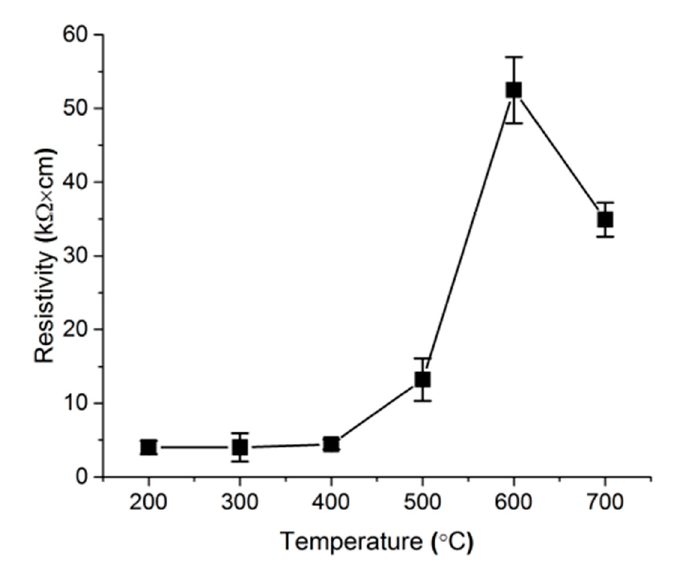
Figure 4. Resistivity of ZnO NRs array grown on a SL annealed at different temperatures.